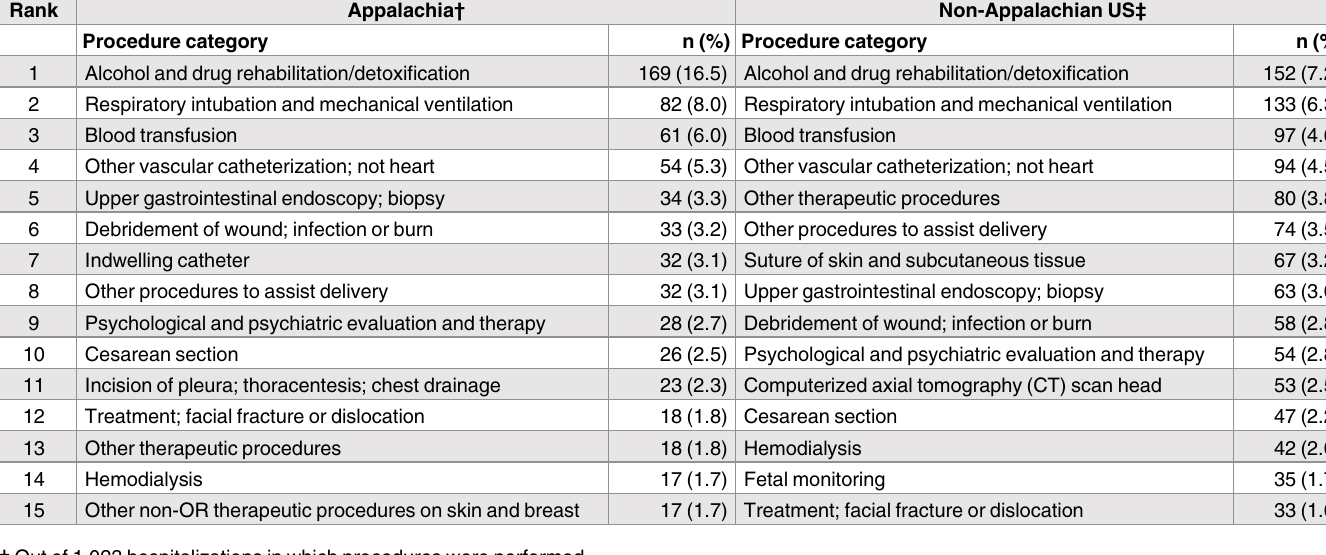
Table 4. Top fifteen primary procedures for IPV-related hospitalizations in Appalachia and non-Appalachian counties in the US,